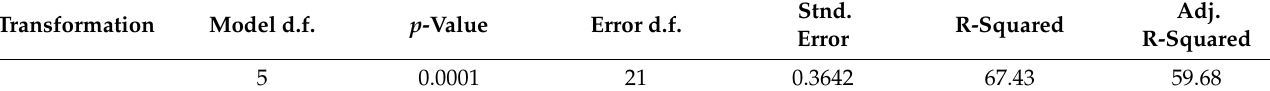
Table 2. ANOVA variance analysis Data.